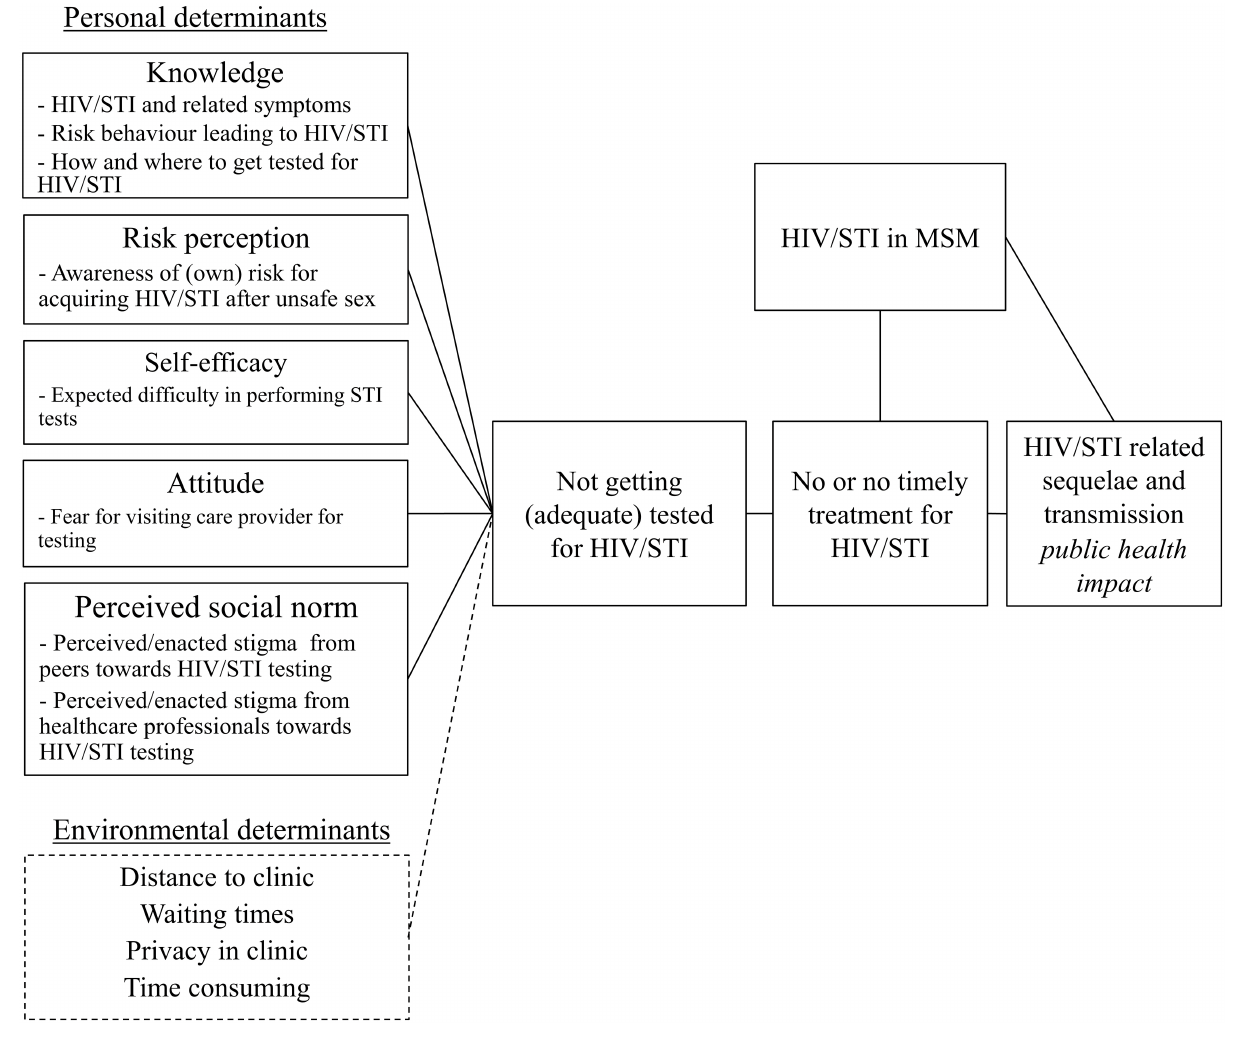
FIGURE 1 | Logic model of the problem regarding lack of HIV/STI testing among men who have sex with